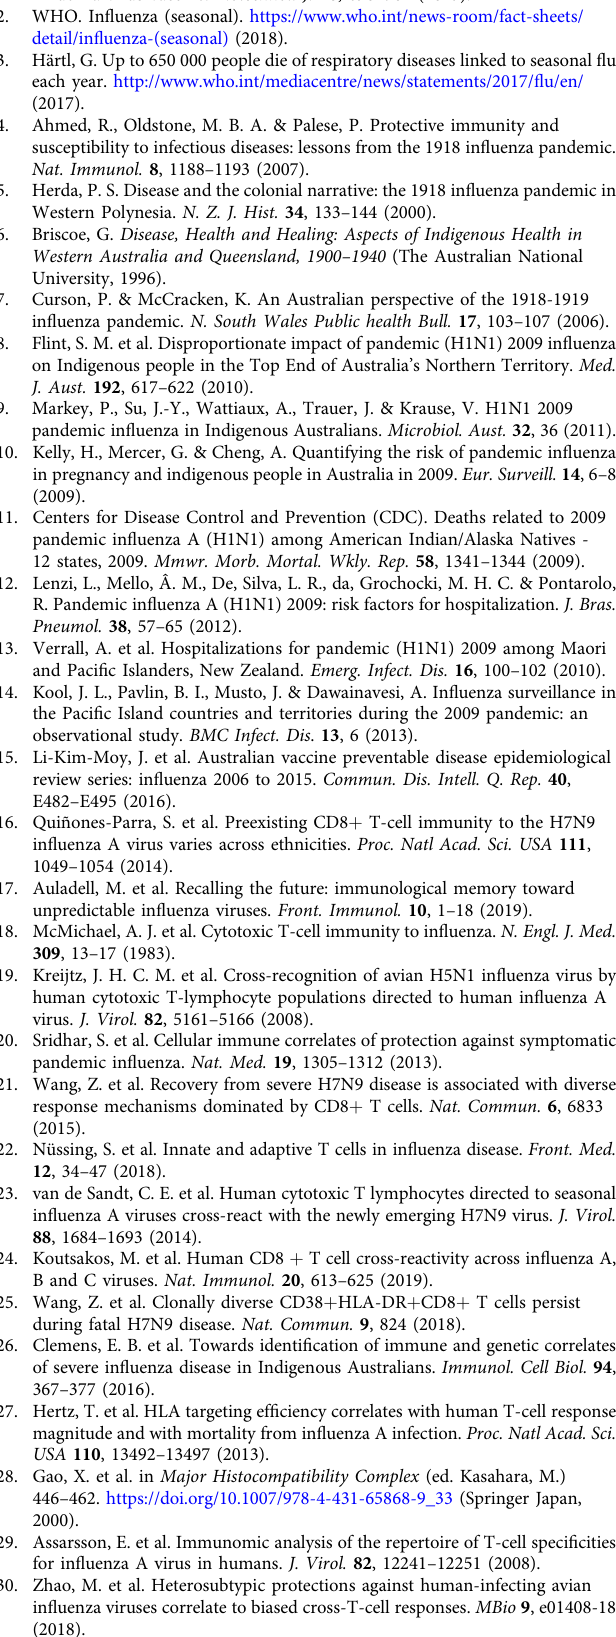
Supplementary Table 5. The fi nal models were deposited in the PDB with the accession codes: 7JYU (HLA-A * A2402-NP 164-173); 6XQA (HLA-A * 24:02- PB2549-557B); 7JYV (HLA-A * A2402-NP 165-173); 7JYW (HLA-A * 24:02- PB2549-557); 7JYX (HLA-A * 24:02-PB2549-559). All molecular graphics repre- sentations were created using PyMol 80